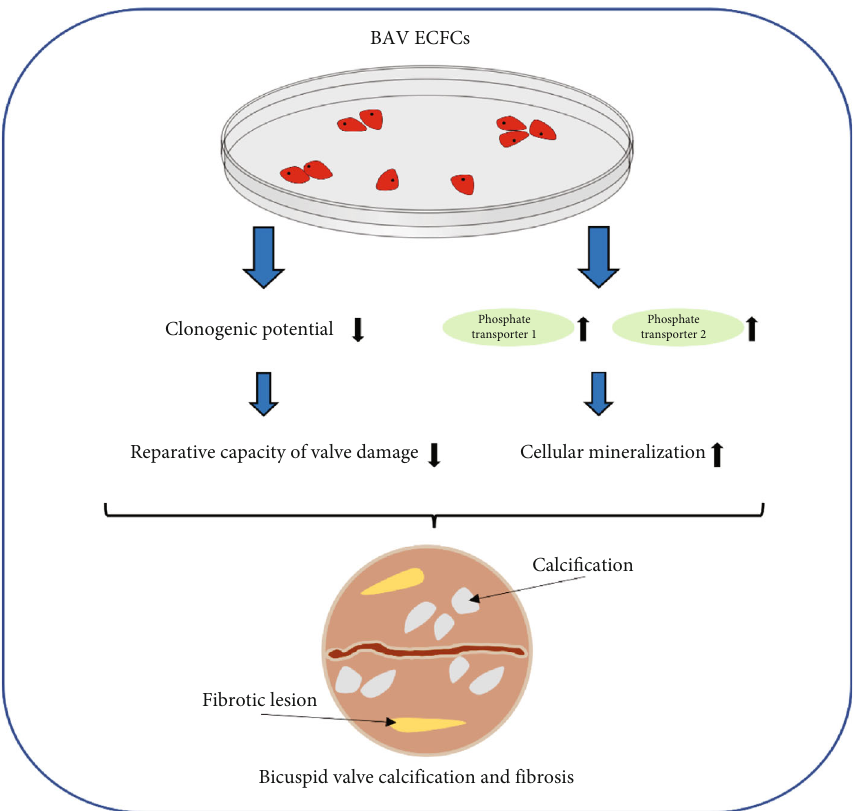
Figure 2: Reduced clonogenic potential and increased production of mineralization promoters (phosphate transporters 1 and 2) in BAV ECFCs may contribute to BAV